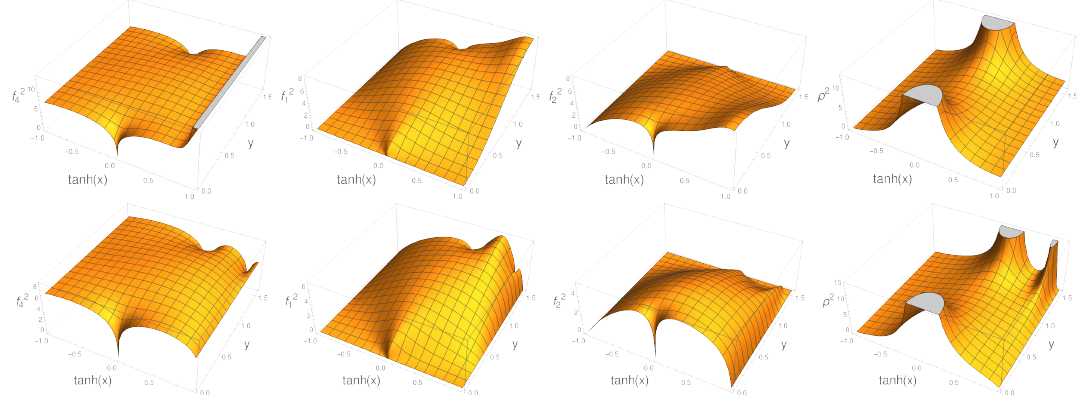
Figure 5. Top row: from left to right the Einstein-frame metric functions f 2 ansatz (2.4) with z = x + iy for the BCFT dual (2.8) with N 5 /K = 12 . Bottom row: same functions for the 3d dual